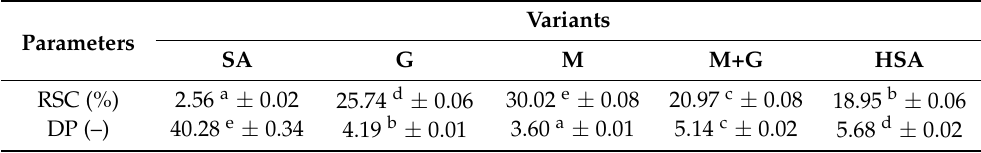
Table 1. Reducing sugar content and the calculated degree of depolymerization of native and hydrolysated alginate .